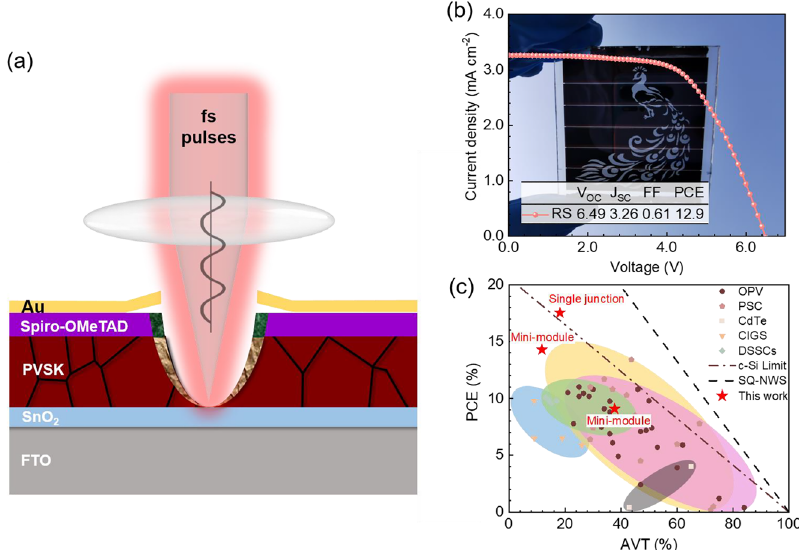
Figure 1: Semi-transparent perovskite solar cells (ST-PSCs) prepared by femtosecond laser direct